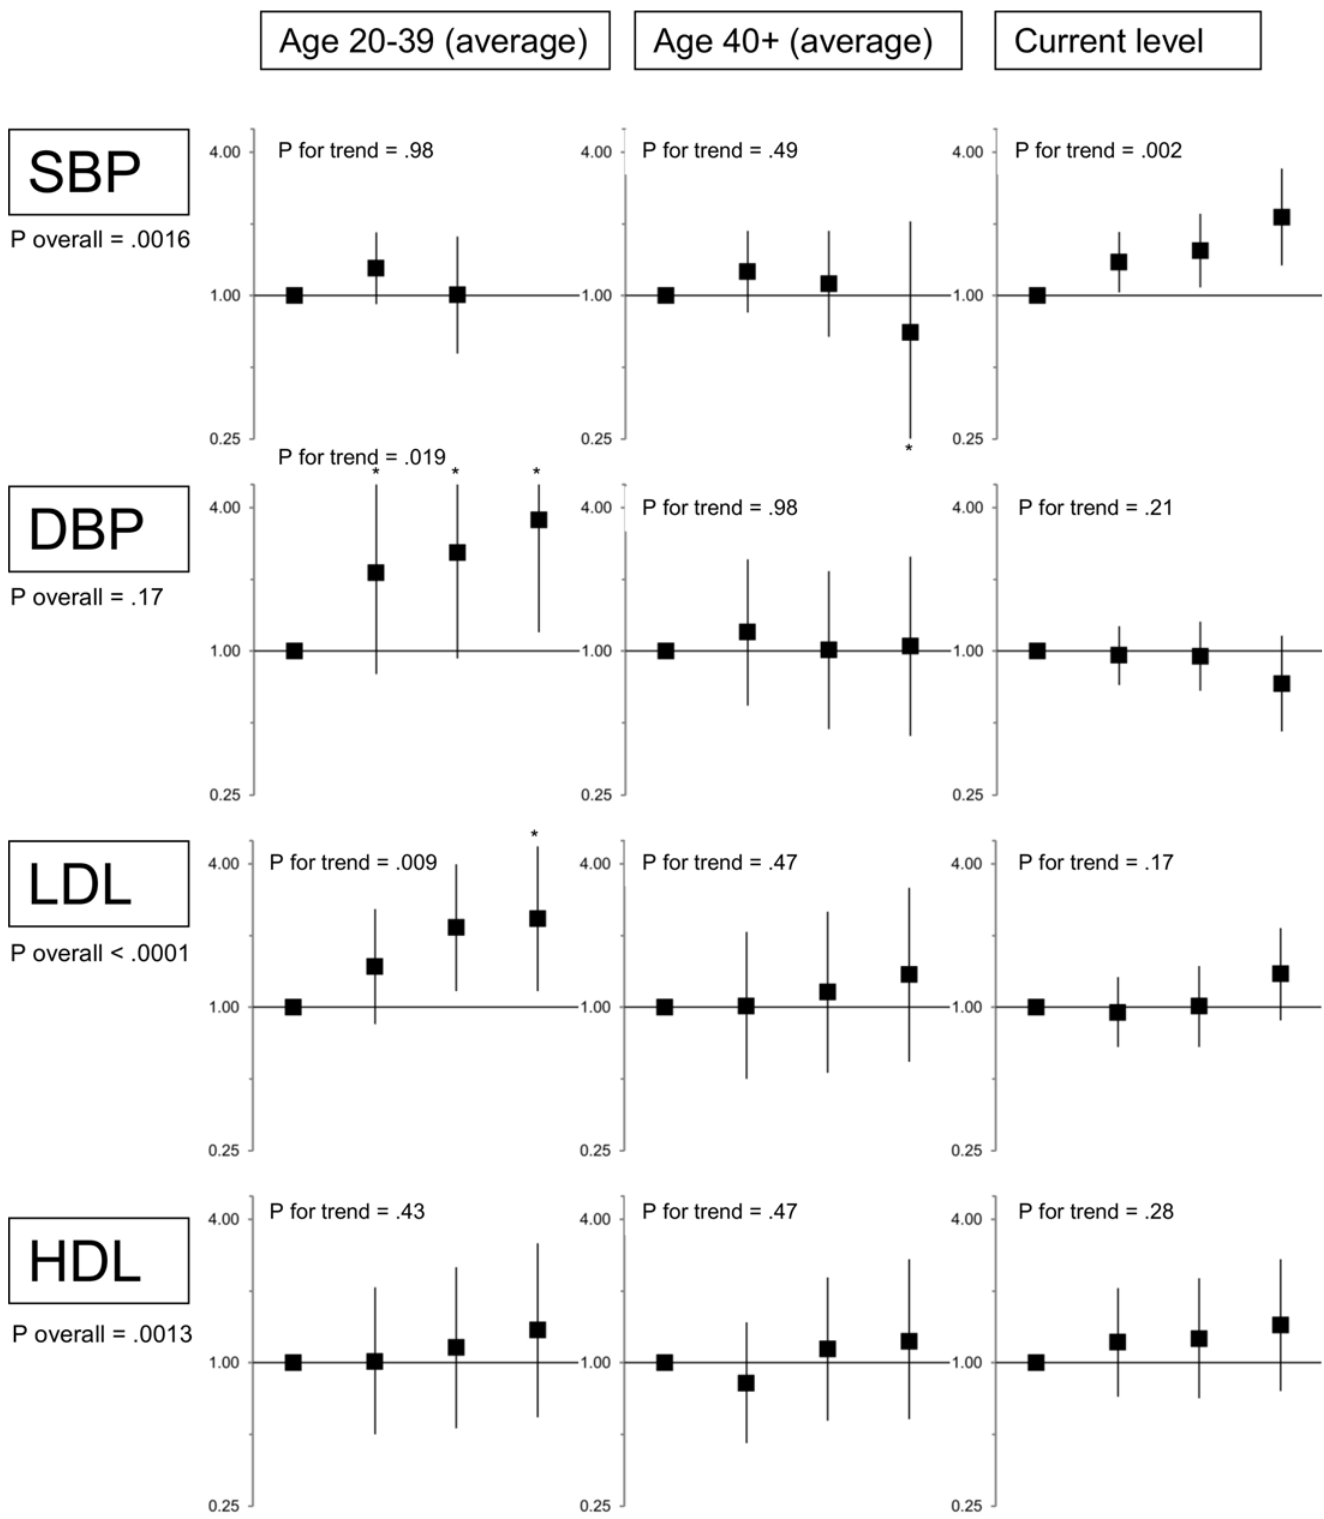
Fig 1. Adjusted associations between SBP, DBP, LDL and HDL levels at different ages and CHD events. Hazard ratios (95% confidence intervals) are adjusted for age (via Cox model), sex, calendar year (via spline), body mass index, diabetes, years with diabetes, smoking status (current/past/